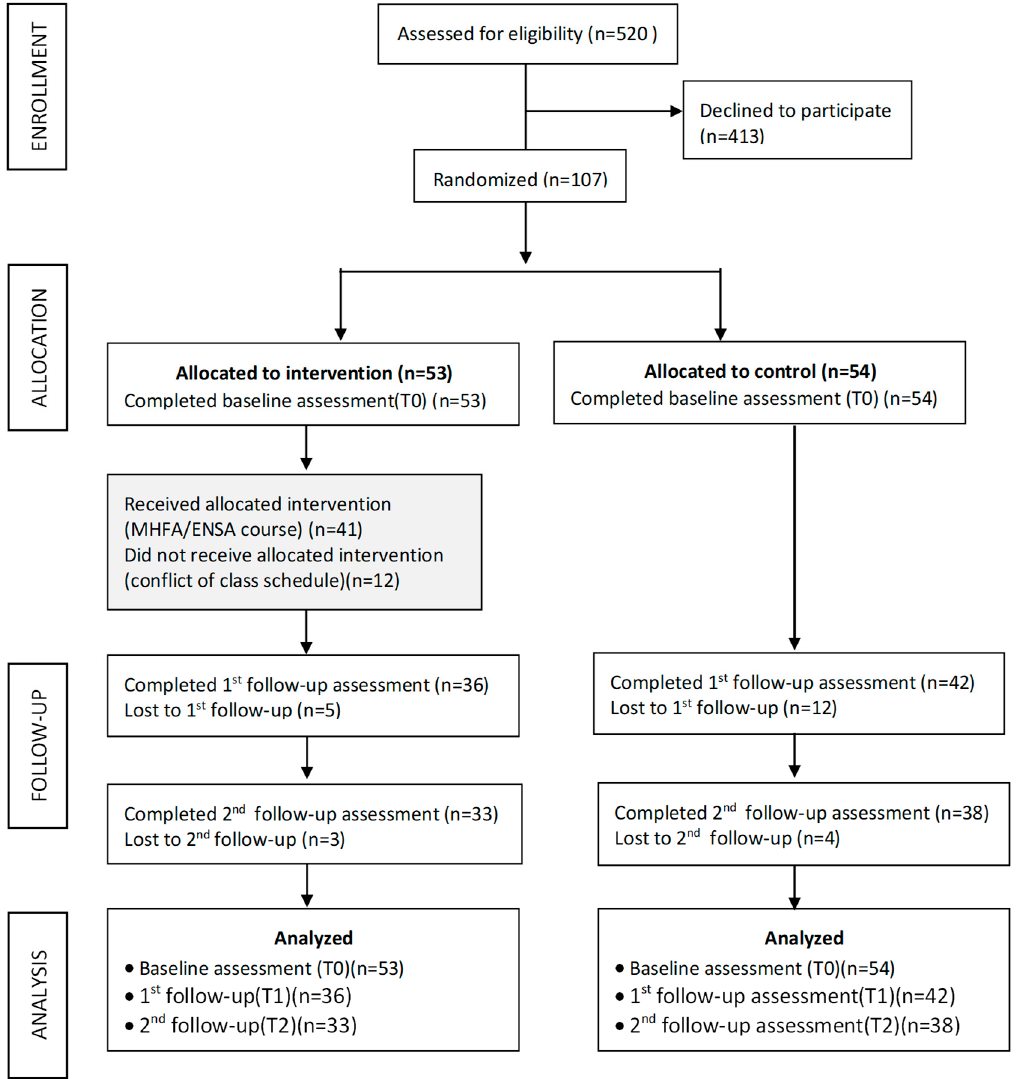
Figure 1. Flow diagram of participant recruitment.